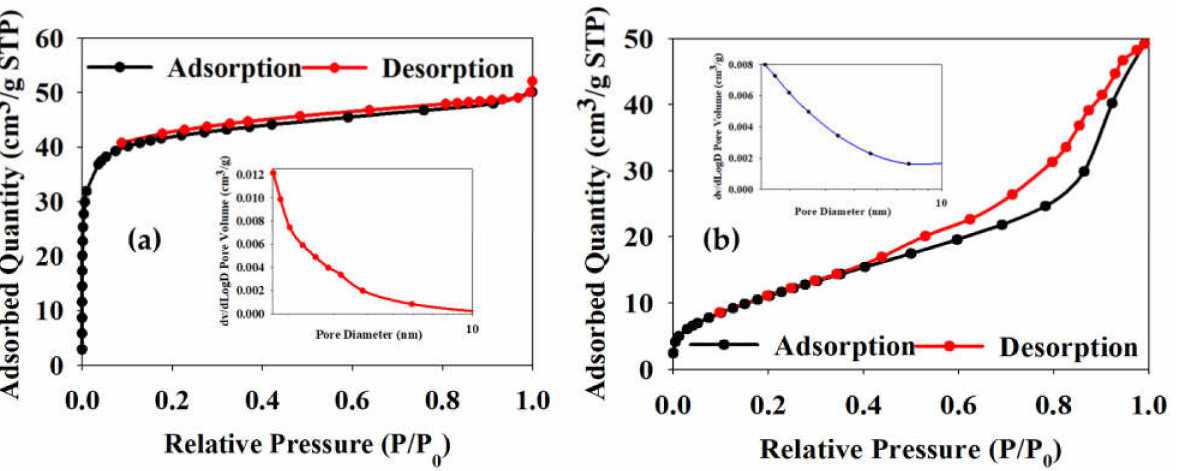
Figure 5. N 2 adsorption–desorption isotherm curve at 77 K for ( a ) SynTiO 2 and ( b ) Mo/SynTiO 2 material